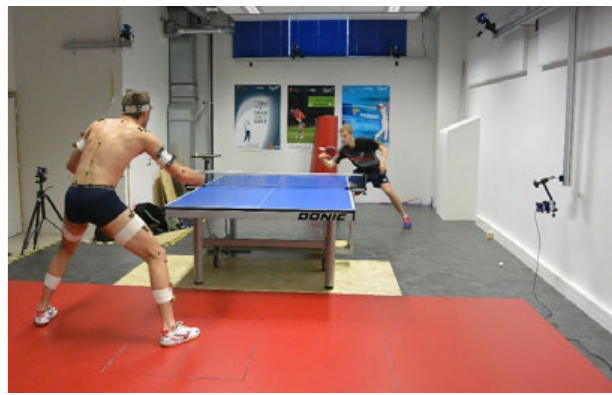
Figure 1 . Photo of the research station